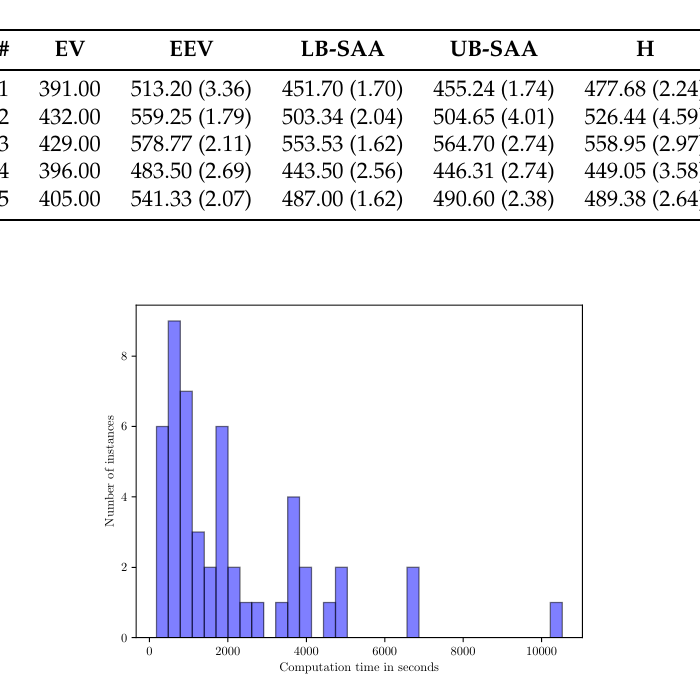
Table 2. Computational results for the small-scale instances. The values in brackets for the columns EEV, LB-SAA, UB-SAA, and H denote the standard deviation of these estimates.